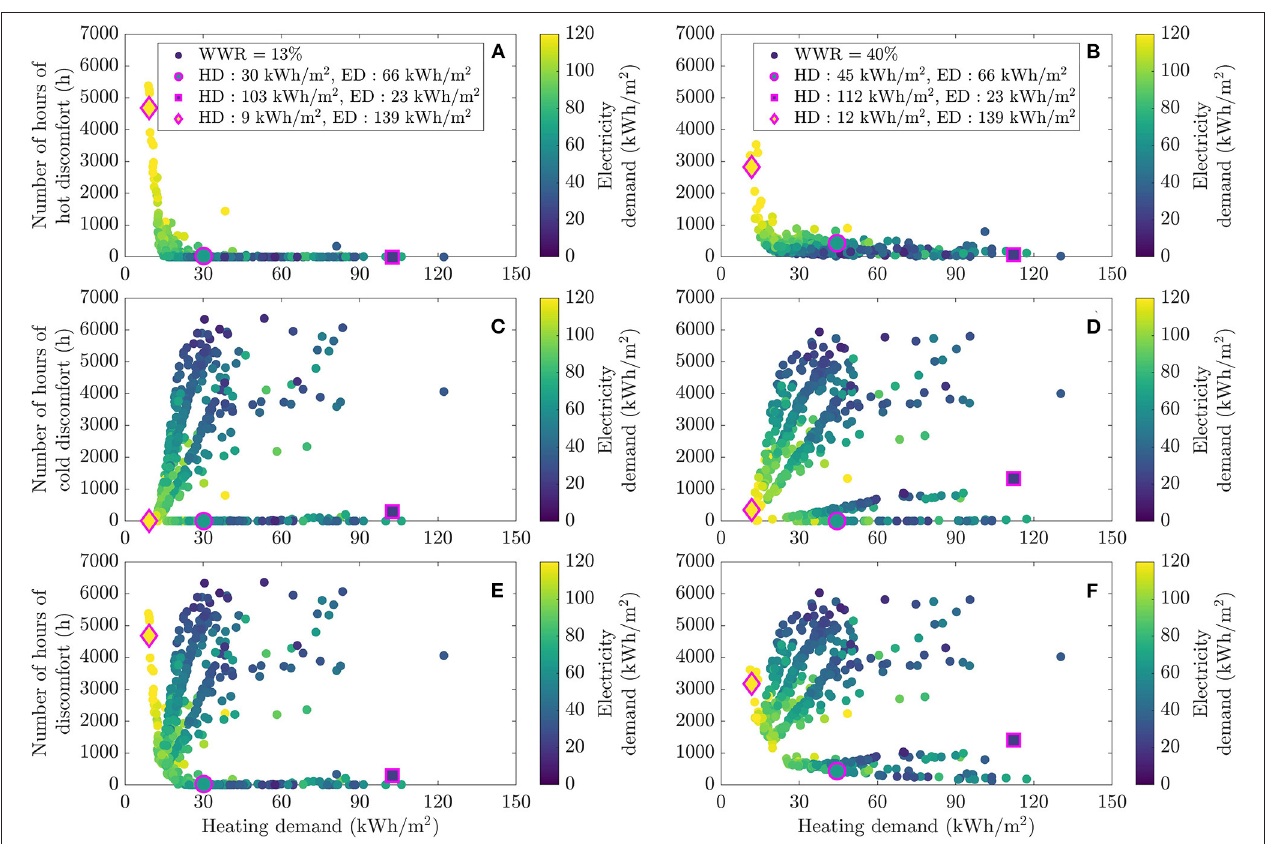
FIGURE 8 | Energy and comfort performance in the dwelling for different occupant profiles, colored by electricity usage, reporting on hot discomfort (A,B) , cold discomfort (C,D) , and total discomfort (E,F) as a function of heating demand for two WWR values (13% on the left and 40% on the right).